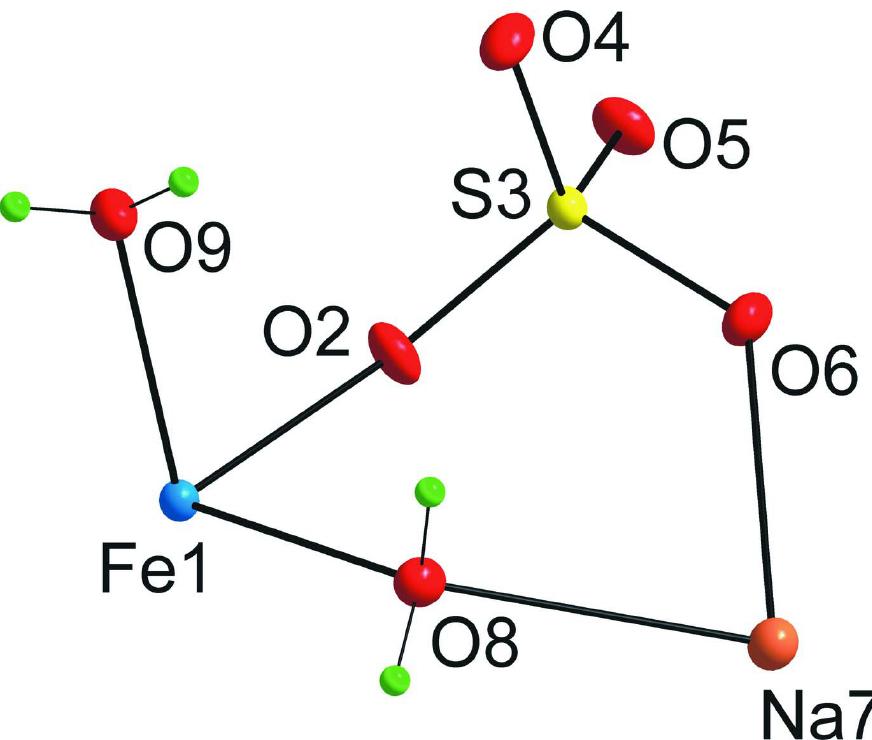
Figure 1 The asymmetric unit of the title compound with displacement ellipsoids shown at the 30% probability level for non-H